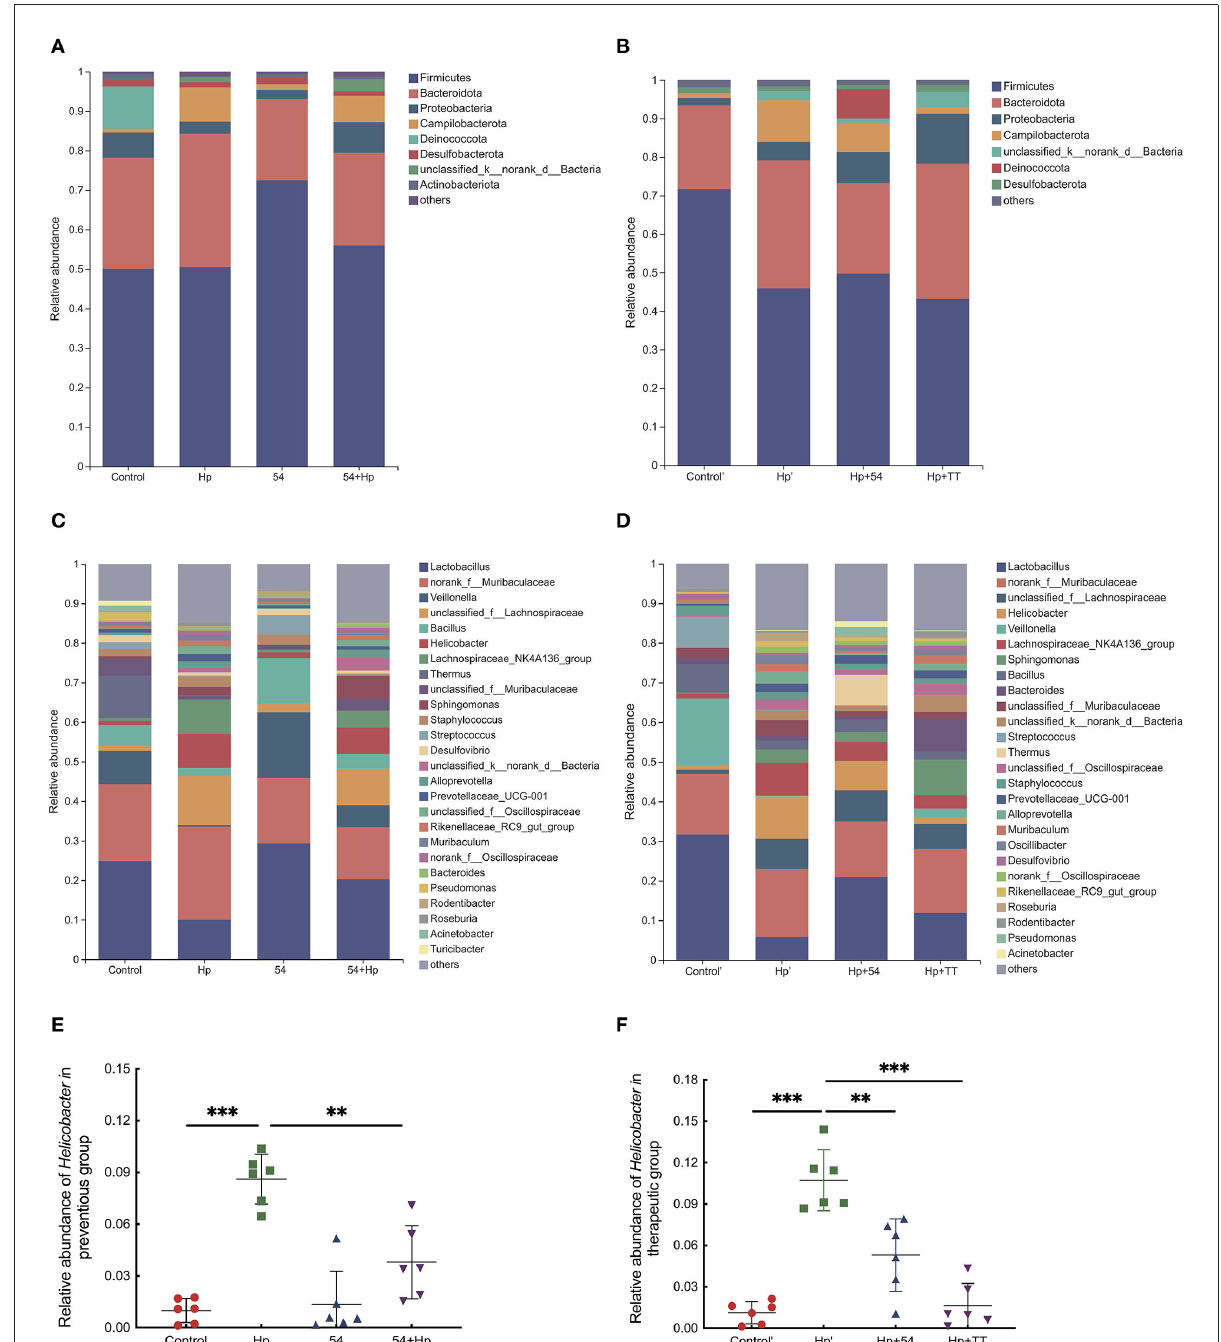
FIGURE8 Bacterial community distribution among different groups at the phylum and genus levels. (A) Distribution of abundant phyla in the preventive group. (B) Distribution of abundant phyla in the preventive group. (C) Distribution of abundant genera in the preventive group. (D) distribution of abundant genera in the therapeutic group. (E) The relative abundance of Helicobacter in the preventive group. (F) The relative abundance of Helicobacter in the therapeutic group. Phyla with a mean abundance < 1.0% and genera with a mean abundance < 1.5% among all samples were consolidated. ** p < 0.01, *** p <